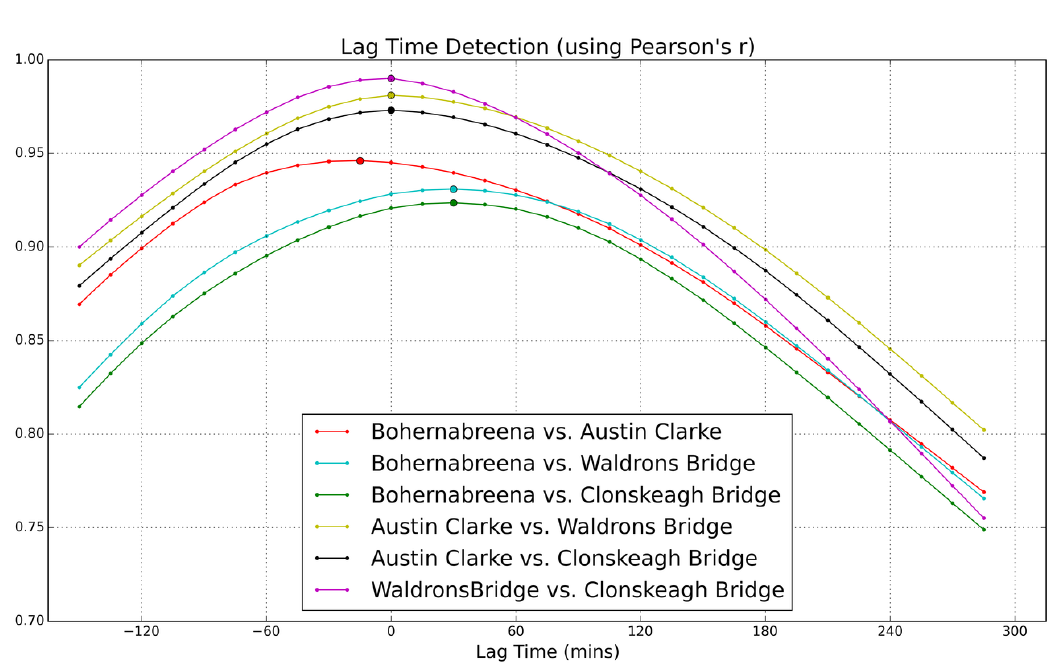
Figure 11. Correlation between the sites along one flow path of the Dodder